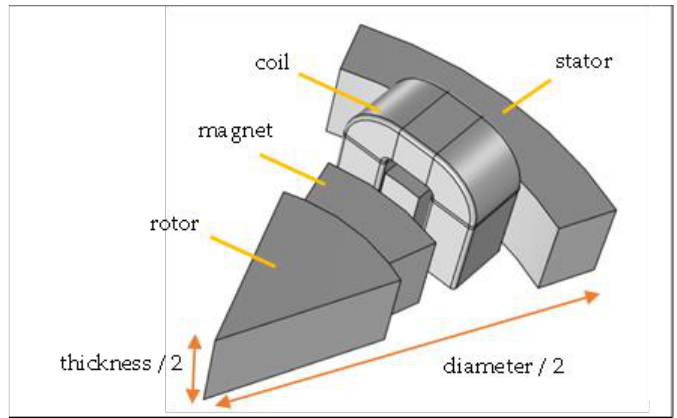
Figure 4. One sector of electromagnetic generator assembly.